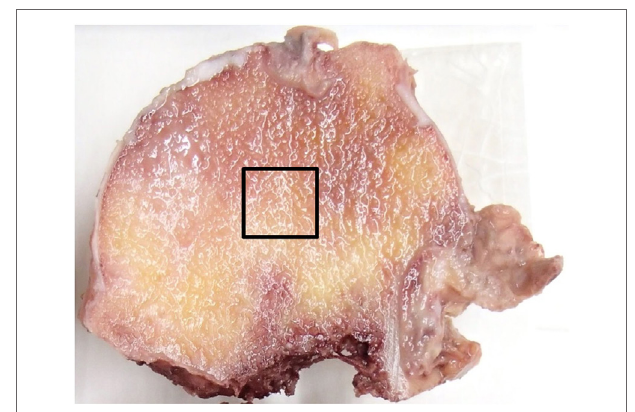
FigUre 1 | Specimen preparation. A bone block of 10 mm × 10 mm × 10 mm was excised from the central region of the femoral head as indicated by the squared